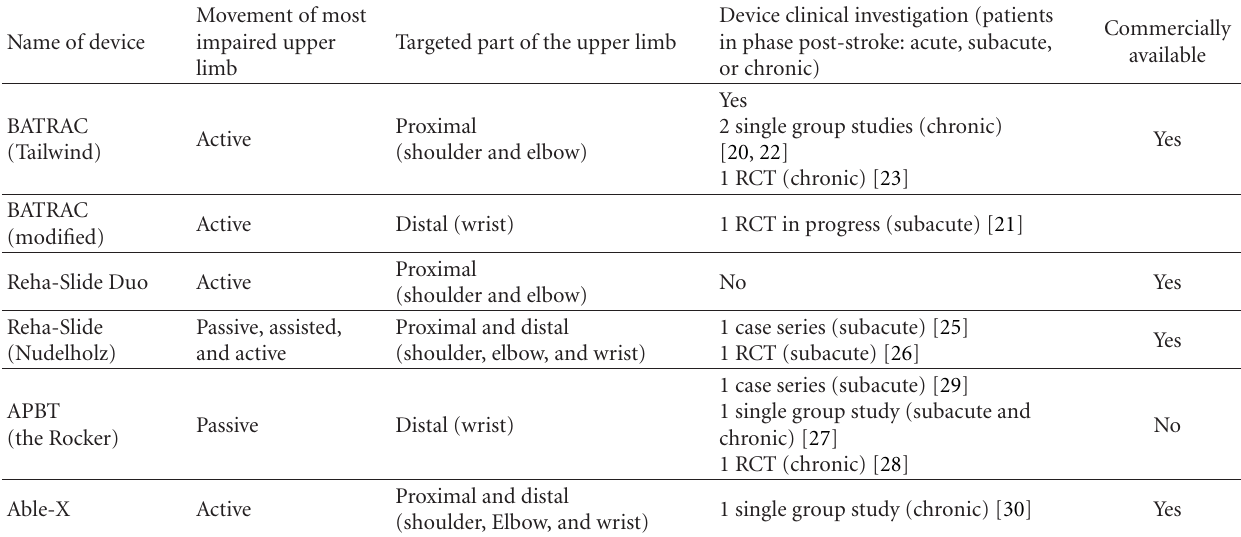
Table 1: Summary of mechanical bilateral upper limb training